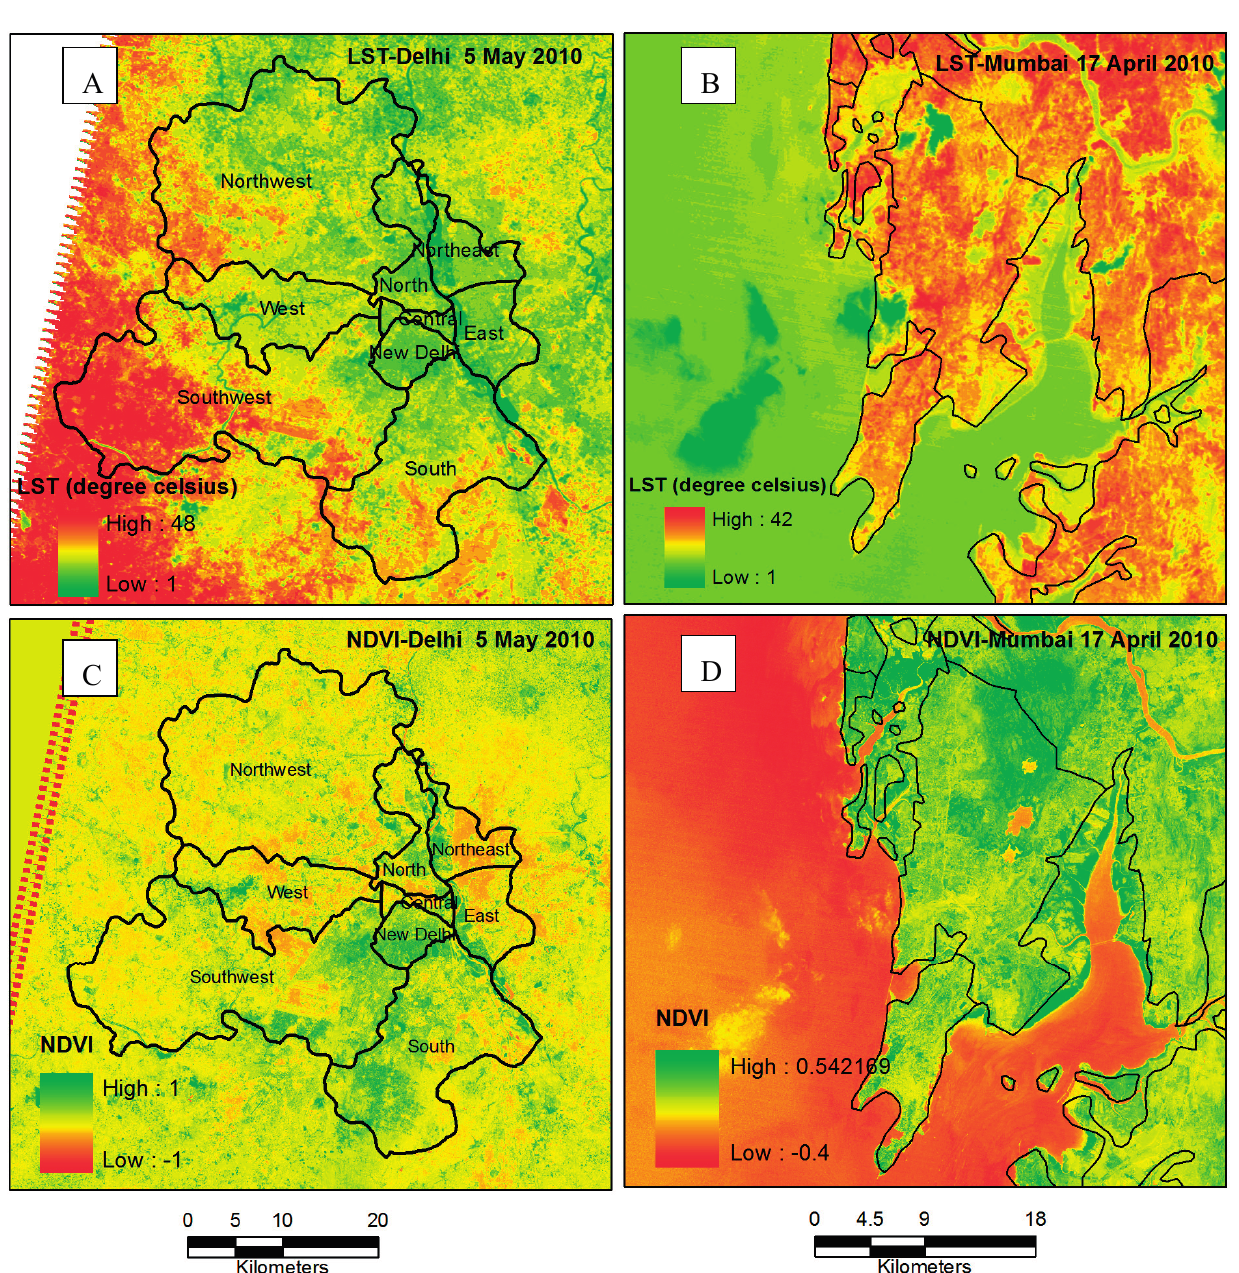
Figure 2. Comparison of the spatial distribution of LST and NDVI values in Delhi and Mumbai. ( A ) LST in Delhi; ( B ) LST in Mumbai; ( C ) NDVI in Delhi; ( D ) NDVI in